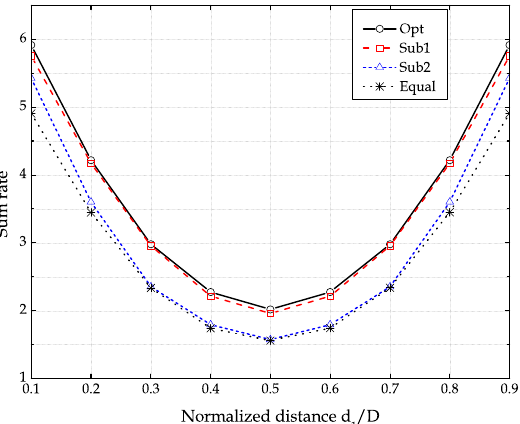
Figure 5. Sum rate of the TS-SWIPT with different resource allocation methods as a function of d 1 / D when P = 20 dBm and ν = 3.